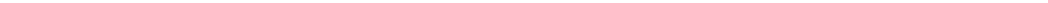
Fig. 4 miRNA-seq analysis allows identi fi cation of progeny-speci fi c miRNA cocktails for propensity perturbation. a Variance vs norm count plot of all detected miRNAs in fi broblast- and MAB-MiPs. Data points depict average values of detected miRNAs. miRNAs associated with pluripotency and with muscle mesoderm are highlighted. b Unbiased clustering of all MiP and parental iPSC samples analyzed by RNA-seq. c PC analysis of all samples reveals stage-speci fi c, progeny-speci fi c clustering. d Heatmap ( z -test) of DE miRNAs (threshold, > 10 norm counts) discriminating fi broblast- and MAB-MiPs. e Volcano plot of fold change vs p -value of all DE miRNAs at MiP stage (threshold, P = 0.05, dashed line). Left side of the chart, all genes and highlighted candidates (miRNAs predicted to bind 3 ʹ UTR of MAB-MiP-upregulated genes) enriched in fi broblast-MiPs; right side, genes and candidates (miRNAs predicted to bind 3 ʹ UTR of fi broblast-MiP-upregulated genes) enriched in MAB-MiPs. f Log 2 chart of fold change at MiP stage vs at iPSC stage of signi fi cantly DE miRNAs (threshold, P < 0.05 at MiP stage). Light blue dots depict miRNAs upregulated in fi broblast-iPSCs and fi broblast-MiPs, while light red dots depict upregulated miRNAs in MAB-iPSCs and MAB-MiPs. Circled dots represent the candidates, as identi fi ed in e , with conserved DE trend. g , h Quanti fi cation of MiP myogenic propensity in co-culture with C2C12 myoblasts after seven days of differentiation. Myotubes with three or more nuclei were counted as well as human nuclei contributing to chimeric myotubes. Representative fi elds and quantitation of chimeric myotubes are presented. P < 0.05 vs treated and non treated. Kruskal – Wallis and Mann – Whitney U test; n = 3 replicates per clone. f-, fi broblast-derived, AMC, anti-myogenic cocktail (gene-based), PMC, pro-myogenic cocktail (gene-based), scale bar ∼ 100 µ m. i Immunostaining analysis of hindlimb (gastrocnemius) muscles of dystrophic, immunode fi cient mice injected with AMC- or PMC-treated MiPs. Upper panels show engraftment, lower panels show appearance of human- speci fi c DYS subsarcolemmal pattern in engrafted fi bers. Scale bars, ∼ 100 μ m. j DYS quantitation by protein analysis is reported on the right. In g – i : ns, non signi fi cant difference; * P < 0.05; Kruskal – Wallis test and Mann – Whitney U -test vs own ctrl (scramble oligos), n = 3/cohort. Depicted are average ± st. dev bars. f-, fi broblast-derived, DE, differentially expressed, AMC, anti-myogenic cocktail (miRNA-based), PMC, pro-myogenic cocktail